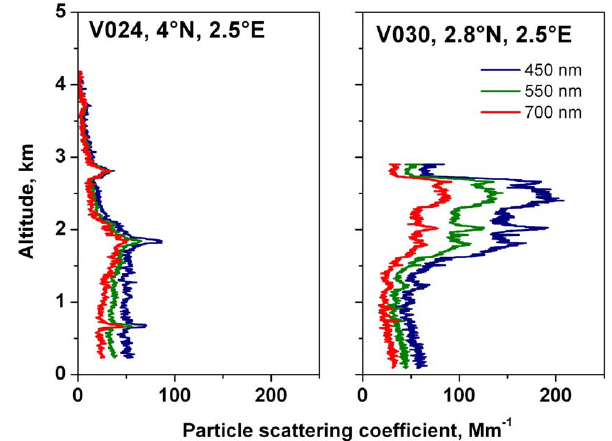
layer remains unperturbed. This additional layer contributes 0.15 to the column scattering optical depth (obtained by